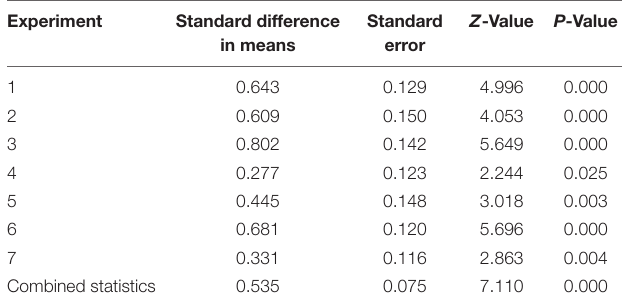
TABLE 1 | Results of meta-analysis of the seven